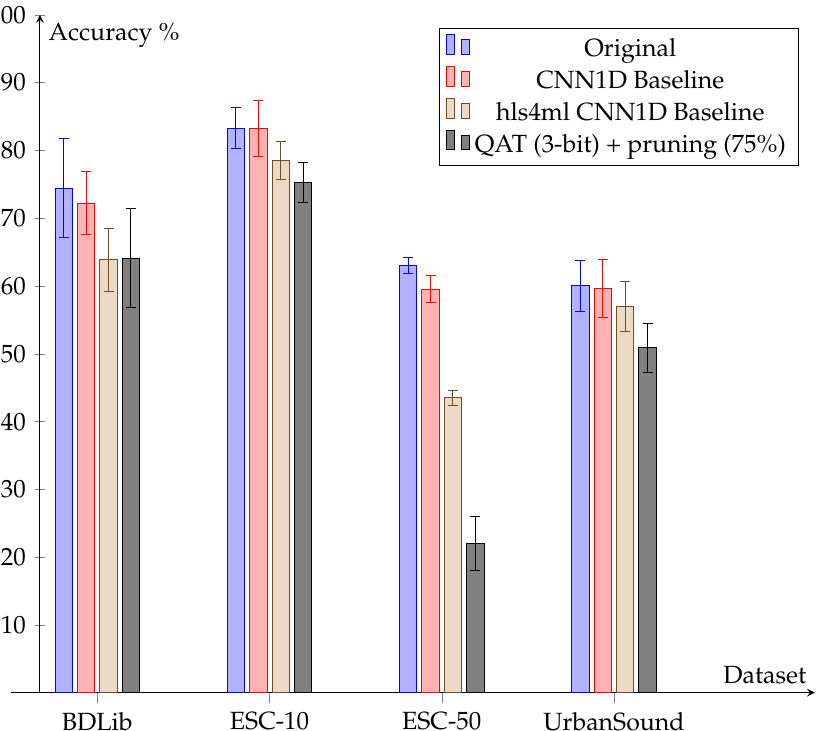
Figure 10. Accuracy evolution after modifications and optimizations for the CNN1D model.